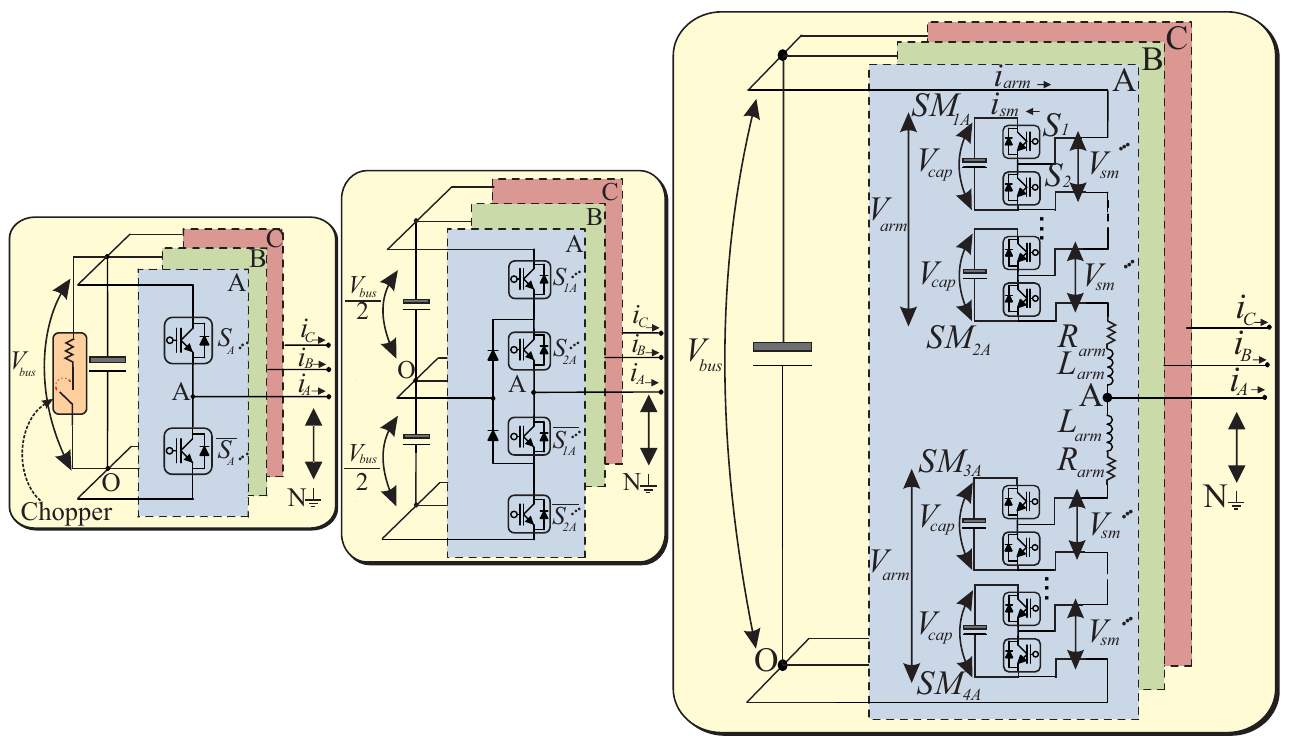
Figure 1. Three-phase converter topologies: 2L-VSC, 3L-NPC, and 3L-MMC. The 3L-MMC topology is composed of series-connected half-bridge submodules, where each submodule has two switches ( S 1 and S 2 ) and one capacitor C SM . In addition, each arm has a series R-L ( R arm and L arm ) impedance equally distributed among the converter phases [11,12]. Table 3 summarizes the main differences between the three presented topologies. Table 3. Comparative summary between the VSC, NPC, and MMC for any level. Criterion